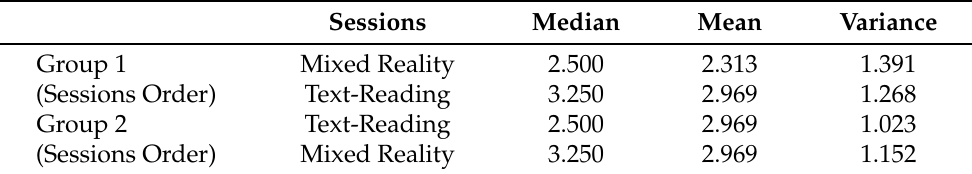
Table 3. Statistics (median, mean, and standard deviation) of retentive score on different methods by groups of